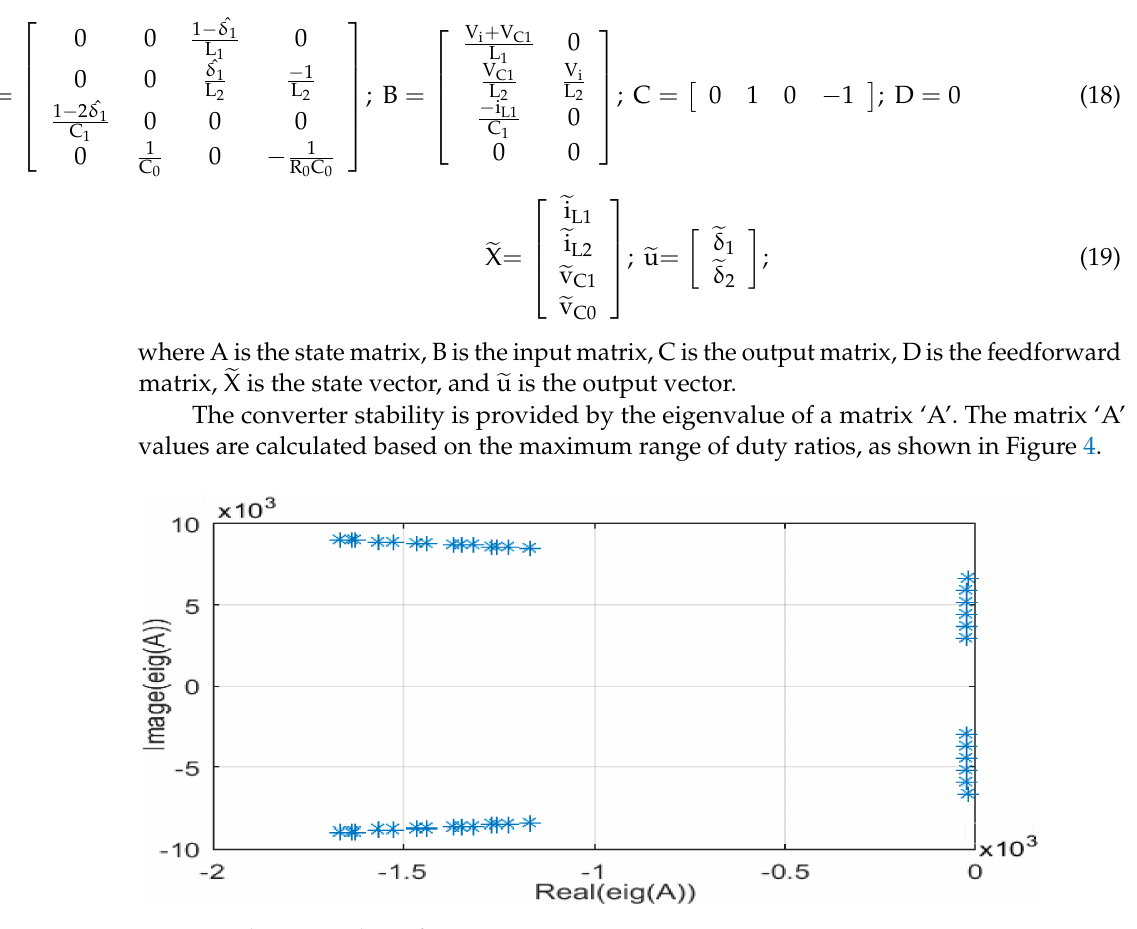
Figure 4. The Eigenvalues of matrix